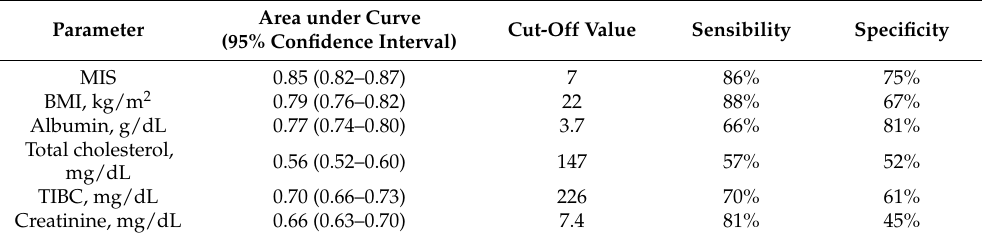
Table 3. ROC curve analysis performed to evaluate prediction of